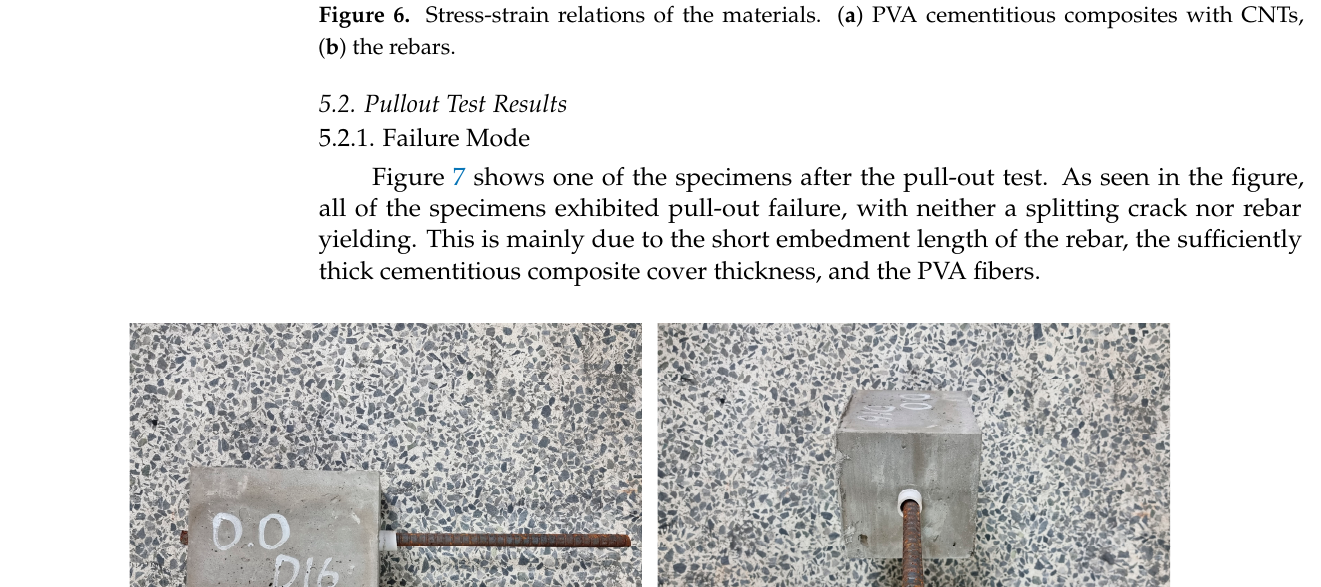
Figure 6. Stress-strain relations of the materials. ( a ) PVA cementitious composites with CNTs, ( b ) the rebars.